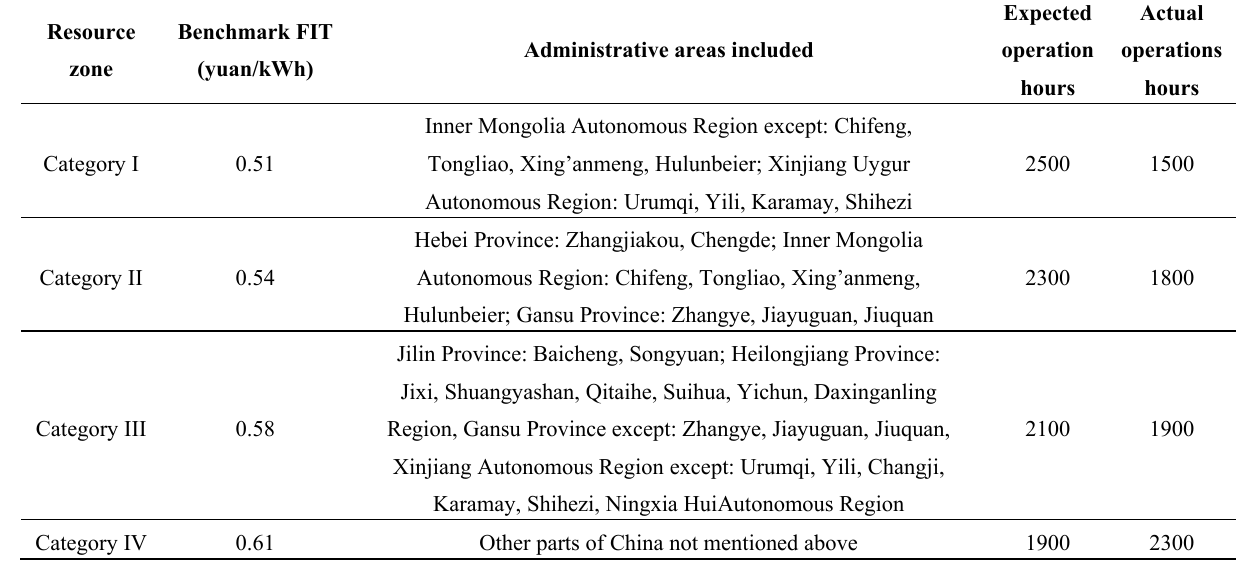
Table 4. Planned and actual operation hours of wind farms in different resource zones in China. Resource